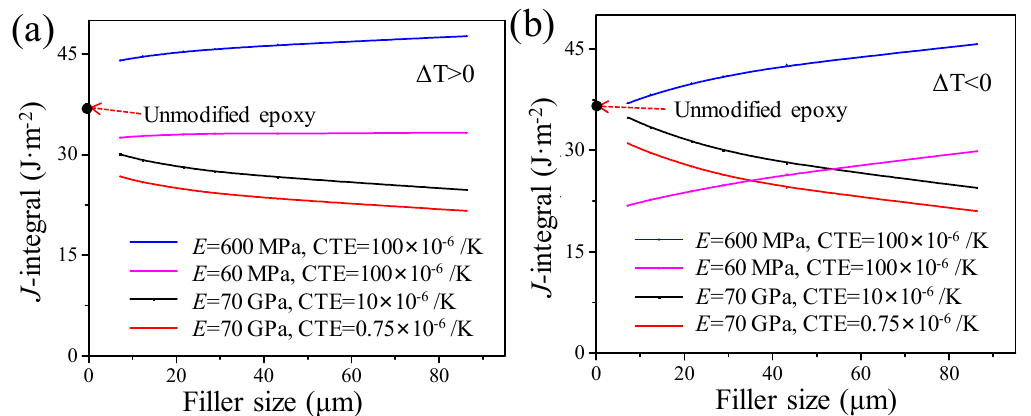
Figure 8. Effect of the diameter of round fillers on interfacial J i values due to thermal shock. ( a ) ∆ T > 0; and ( b ) ∆ T < 0.